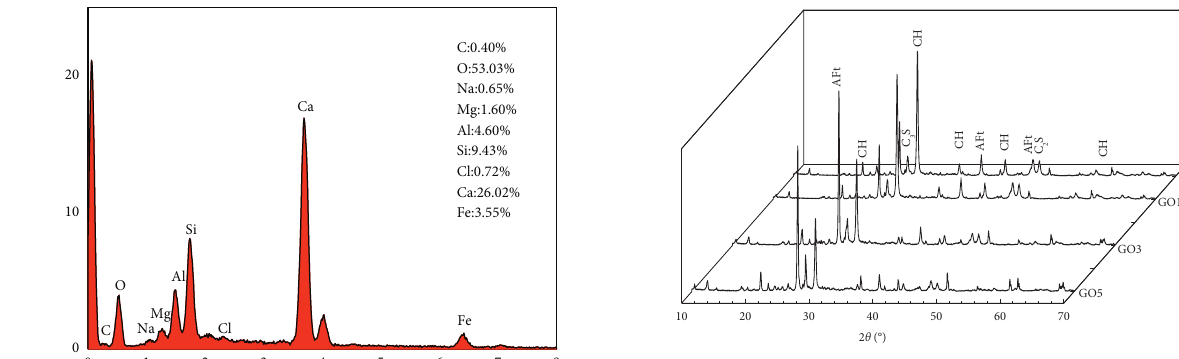
Figure 14: XRD patterns of GO concrete. 0